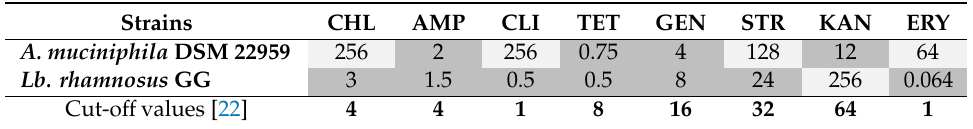
Table 1. Antimicrobial susceptibility of A. muciniphila DSM 22959 and Lb. rhamnosus GG against chloramphenicol (CHL), ampicillin (AMP), clindamycin (CLI), tetracycline (TET), gentamicin (GEN), streptomycin (STR), kanamycin (KAN), and erythromycin (ERY), as determined with Etest. MIC values were expressed as µ g / mL.